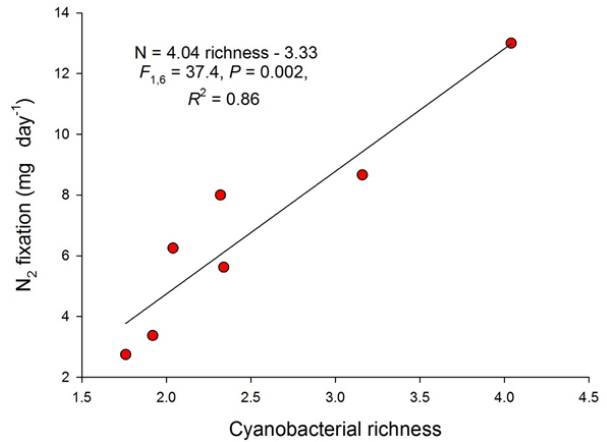
Figure 7. Relationship between cyanobacterial richness and N- fixation rates. As shown, N fixation increases significantly with in- creases in cyanobacterial richness.